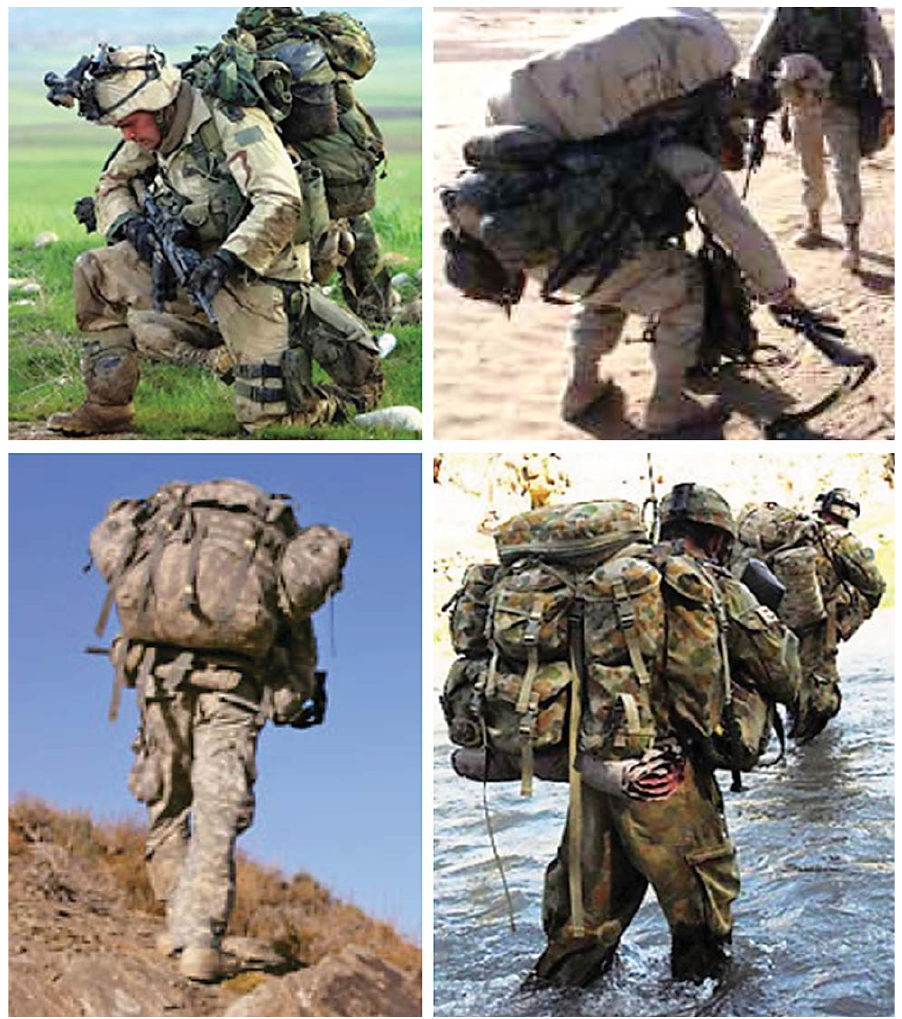
Fig. 1. Field operations of infantrymen in carrying loads